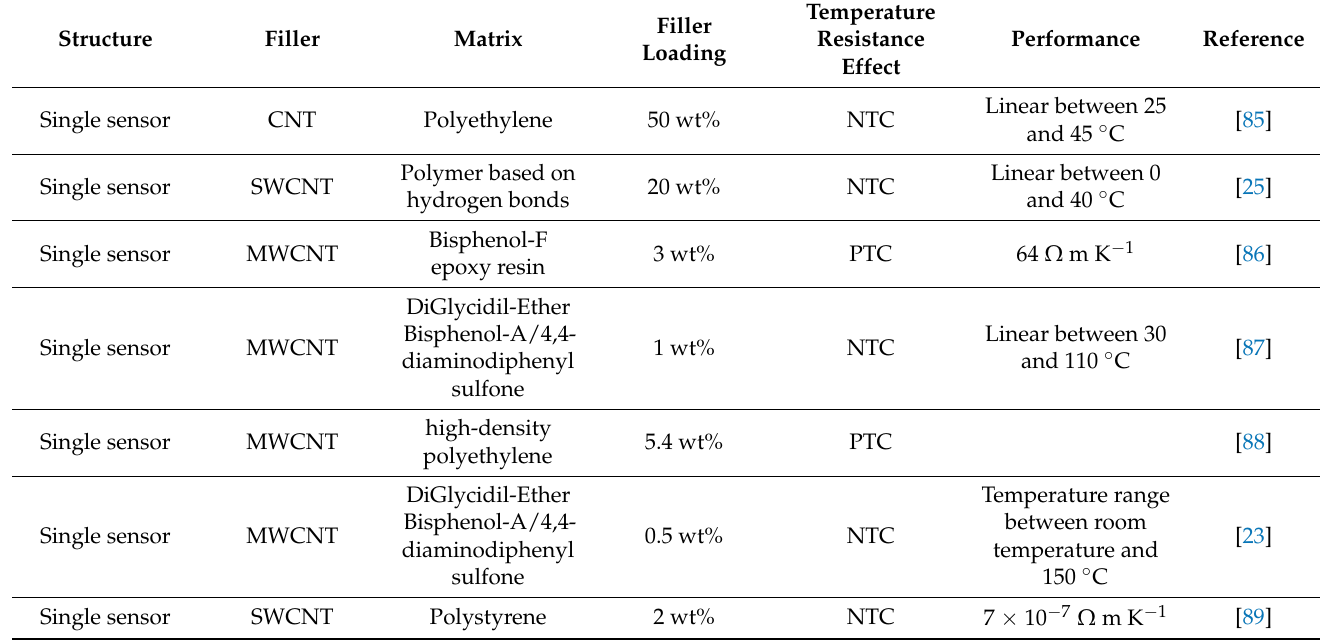
Table 7. Several thermal sensing